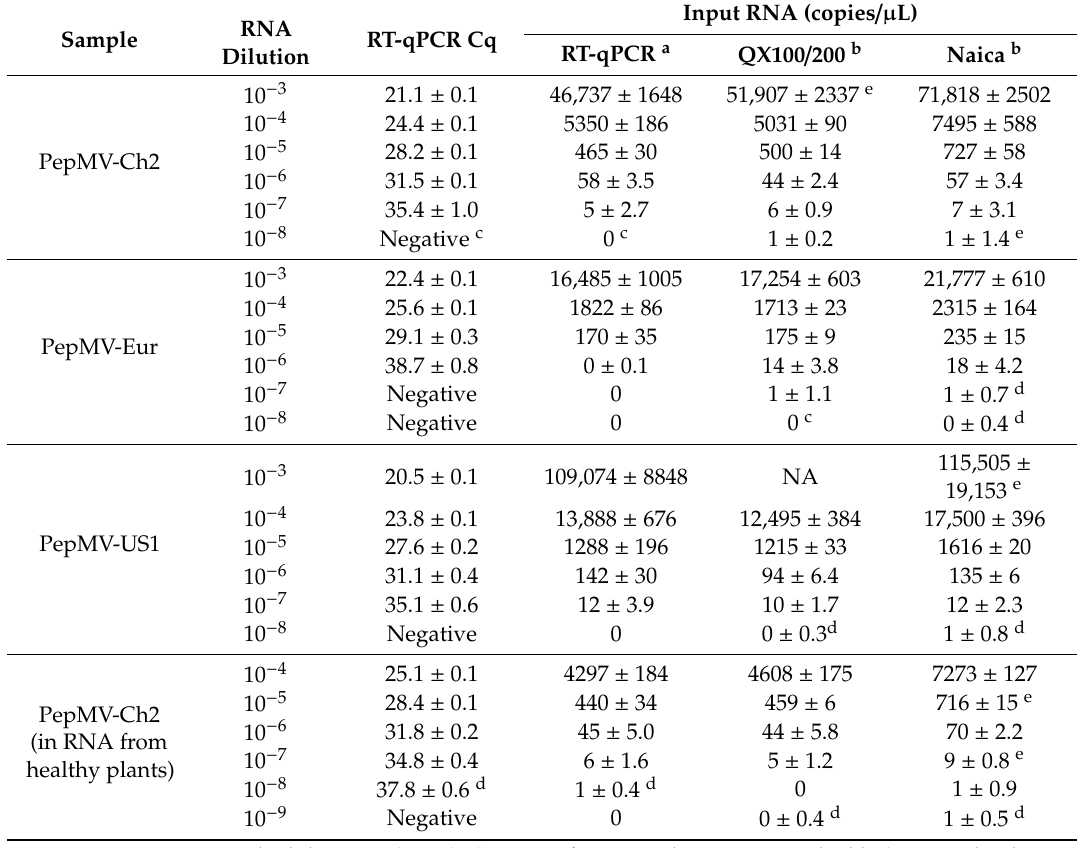
Table 3. Sensitivities of the RT-qPCR and RT-dPCR assays for